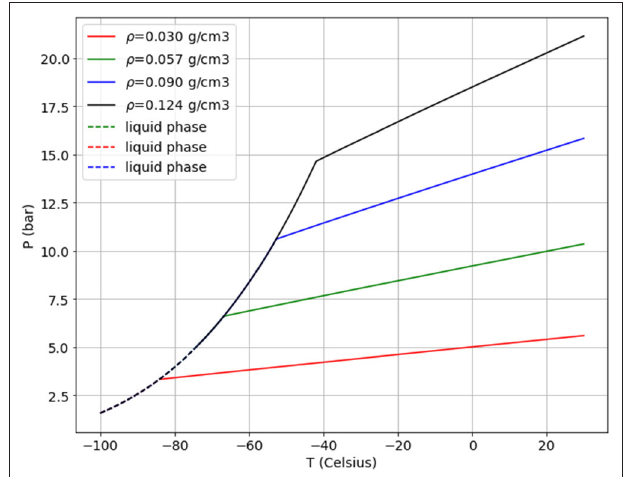
FIGURE 1 | Isochoric curves for xenon at different